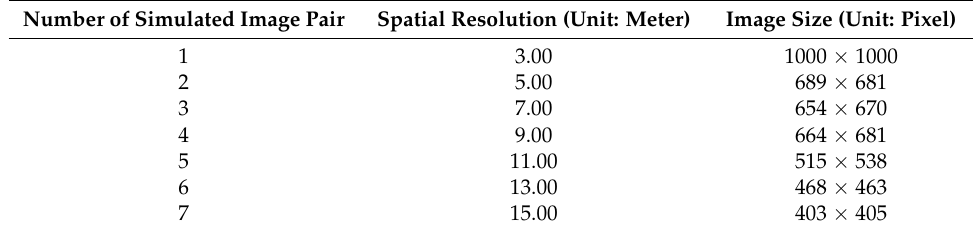
Table 4. Information of the dataset simulated from image pair 11.